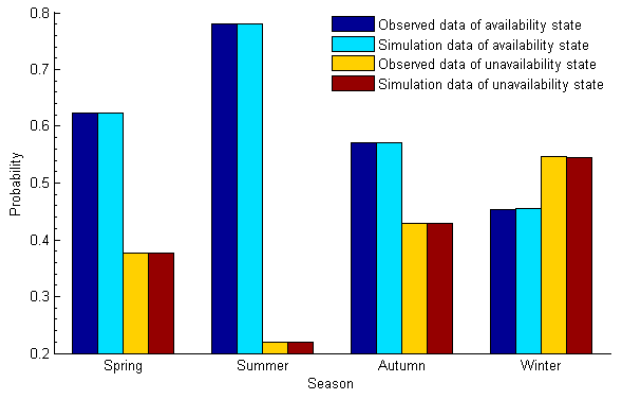
Figure 13. The probability of each state occurring in different seasons.